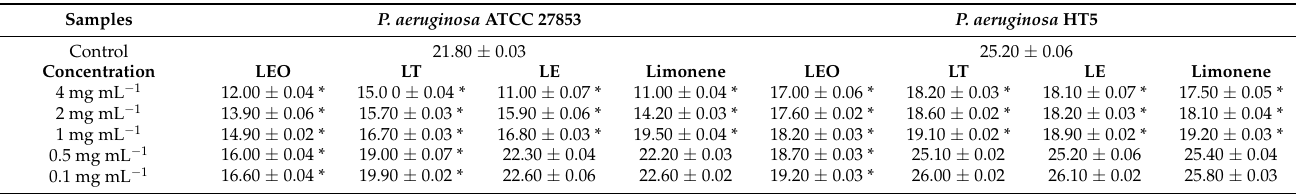
Table 3. Pseudomonas aeruginosa swimming motility.